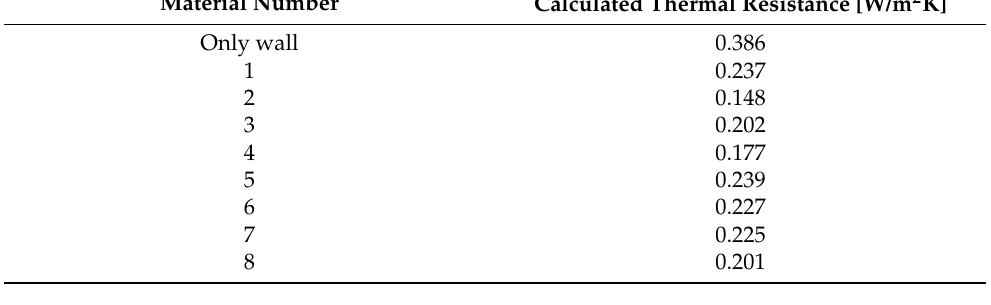
Figure A11. Wall type 4: stratigraphy with thicknesses and conductivities for the different layers. The numbers start from the outside. Table A6. Wall type 4: thermal transmittance reached with different heat-reflective materials.